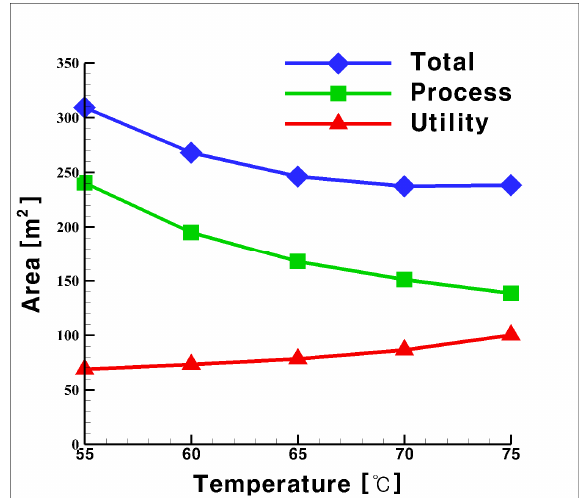
Figure 10. Changes in the area as a function of temperature in each group when using glycol water as the heat medium.